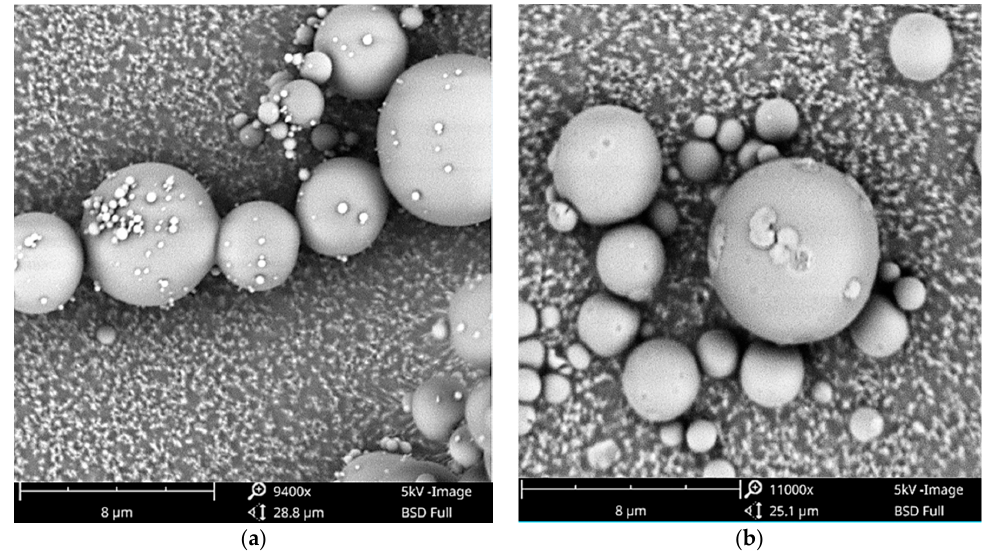
Figure 8. Scanning electron microscope (SEM) observations of NAP/PVA 40:60 ( w / w ) produced by ( a ) atomization device and ( b ) spray dryer.